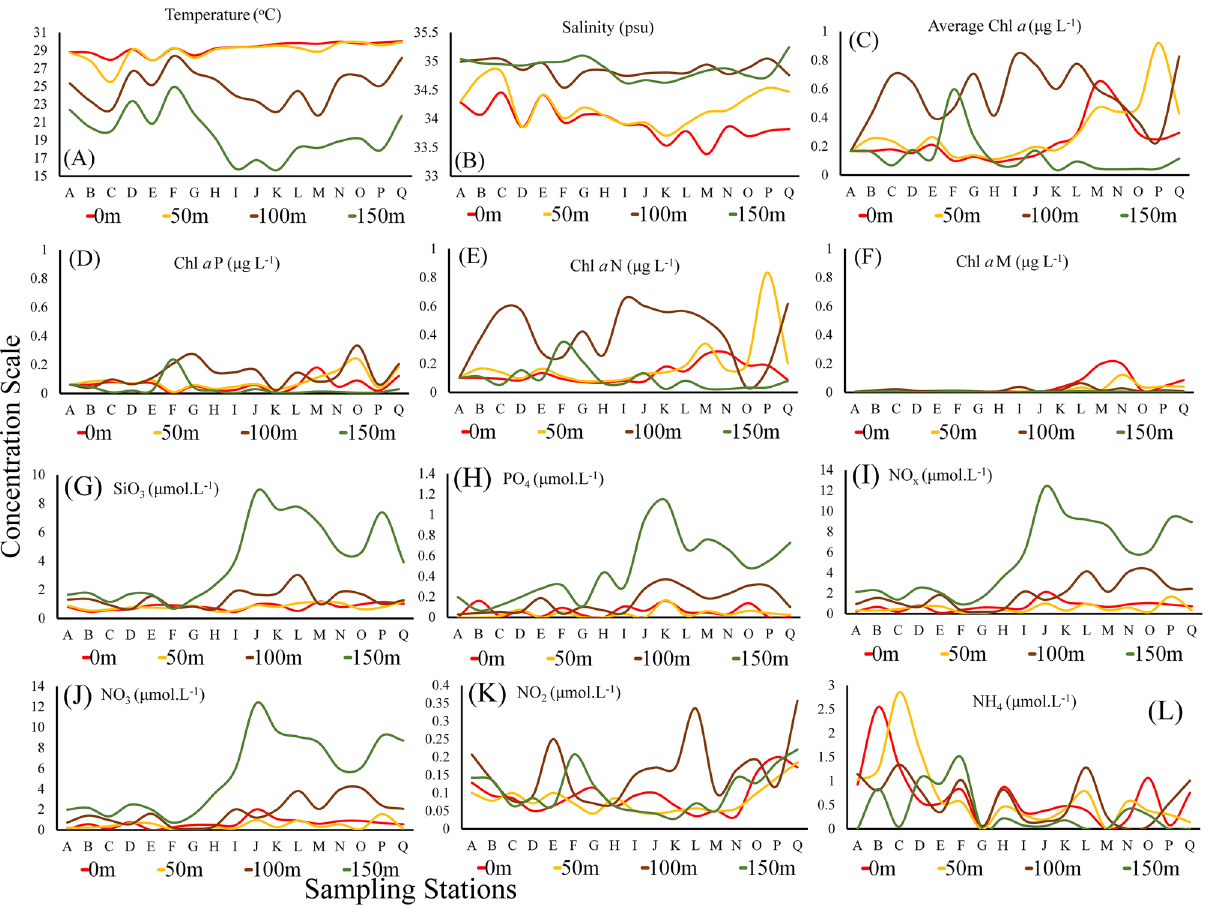
Figure 3. Different environmental parameters, i.e., Temperature ( A ), salinity ( B ), average Chl -a ( C ) and size- fractionated chl -a, i.e., Chl a-P (pico chlorophyll), Chl a-N (nano chlorophyll) and Chl a-M (micro chlorophyll). Average concentrations of nutrients, i.e., silicates ( G ; SiO 3 ), phosphates ( H ; PO 4 ), nitrous oxides ( I ; NO x ), nitrite ( J ; NO 3 ), nitrate ( K ; NO 2 ) and ammonium ( L ; NH 4 ) at the with ranges of 0.77–1.89 mD −1 , and lower at 0 m (1.26 ± 65 mD −1 ), with ranges of 0.53–1.7 mD −1 (Fig. 6B). Con- sidering the water layers, the average sinking rates were higher at the SCM (1.30 mD −1 ) than at both the MLD (1.26 mD −1 ) and BSCM (1.27 mD −1 ). Considering the vertical segments (Fig. 6C), the average sinking rates were found to be higher at S HE (1.56 ± 0.35 mD −1 ), especially at the BSCM (1.73 ± 0.56 mD −1 ), than at all other sec- tions, i.e., S ME (1.51 ± 0.26 mD −1 ), S NEC (1.07 ± 00.3 mD −1 ) and S KC (1.03 ± 0.17 mD −1 ). However, S ME possessed higher vertical sinking rates at both the MLD (1.53 ± 0.26 mD −1 ) and SCM (1.57 ± 0.22 mD −1 ) than at the other stations (Table 1). A low sinking rate was observed at both the MLD (0.94 ± 0.2 mD −1 ) and SCM of the Kuroshio (1.05 ± 0.14 mD −1 ) as well as at the BSCM of the equatorial current (1.06 ± 0.3 mD −1 ). Environmental correlations among parameters. Correlation plots demonstrated the significant cor- respondences (P < 0.05) of TEPs and sTEP. TEP concentration showed significant negative correlations with temperature (Fig. 7). It showed positive linearity with chl- a , especially at 100 m depth at S ME and S HE (Fig. 8A). However, it maintained negative linearity with sTEP in the same zone at similar depths (Fig. 8B), which is also supported by correspondence analysis (Fig. 7). On the other hand, sTEP demonstrated significant posi- tive correspondences (P < 0.05) with diatoms, cyanobacteria and Chl-a (Fig. 7) and negative correspondences with ammonium (Fig. 7). It also showed a highly significant negative correspondence with atmospheric pres- sure (Atm P) and maintained significant negative linearity (R 2 = 0.4 ~ 0.8) in the regression graphs, especially at 100 m of the WPO (Fig. 8C). Under the SME, sTEP showed positive linearity with cyanobacteria (R 2 = 0.55) at 0 m (Fig. 8D) and with diatoms (R 2 = 0.59) at 50 m (Fig. 8E). In this study, the TEP/Chl-a ratio was positively correlated (R 2 = 0.49) with diatoms (Fig. 8F) with high amplitudes (Fig. 9), especially at the surface (0 m) of the eddies (S ME + S HE ). CCA showed the close correspondence of TEP concentration with cyanobacteria abundances and nutri- ent concentrations (Fig. 10A). Cyanobacteria, i.e., T. hildebrandti and T. theibauti were more closely related to TEP concentration than the other dominant phytoplankton groups (Fig. 10B). Except for Chl -a M, the rest of the size-fractionated chl -a concentrations demonstrated correspondences to TEP concentration at the MLD, which may have demonstrated the resemblances of pico- and nanophytoplankton (Fig. 10C). TEP concentration